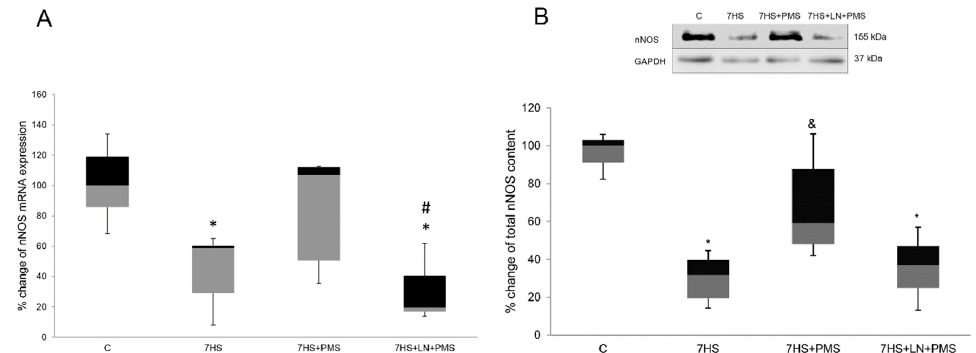
Figure 1. PCR-analysis of nNOS mRNA expression level ( A ), Western-blot analysis of total nNOS content ( B ) in rat soleus muscle in control group (C), 7-day hindlimb-suspended group (7HS), 7-day hindlimb suspended group with plantar mechanical stimulation (7HS + PMS), 7-day hindlimb suspended group with plantar mechanical stimulation+ L-NAME introduction (7HS + LN + PMS). Data are shown as % of the control group. *—significant difference from the control group. &—significant difference from 7HS group. #—significant difference from 7HS + PMS group ( p < 0.05). Box plots show 25–75 percentiles and median values and the whiskers represent the minimum and the maximum; n = 8/group.